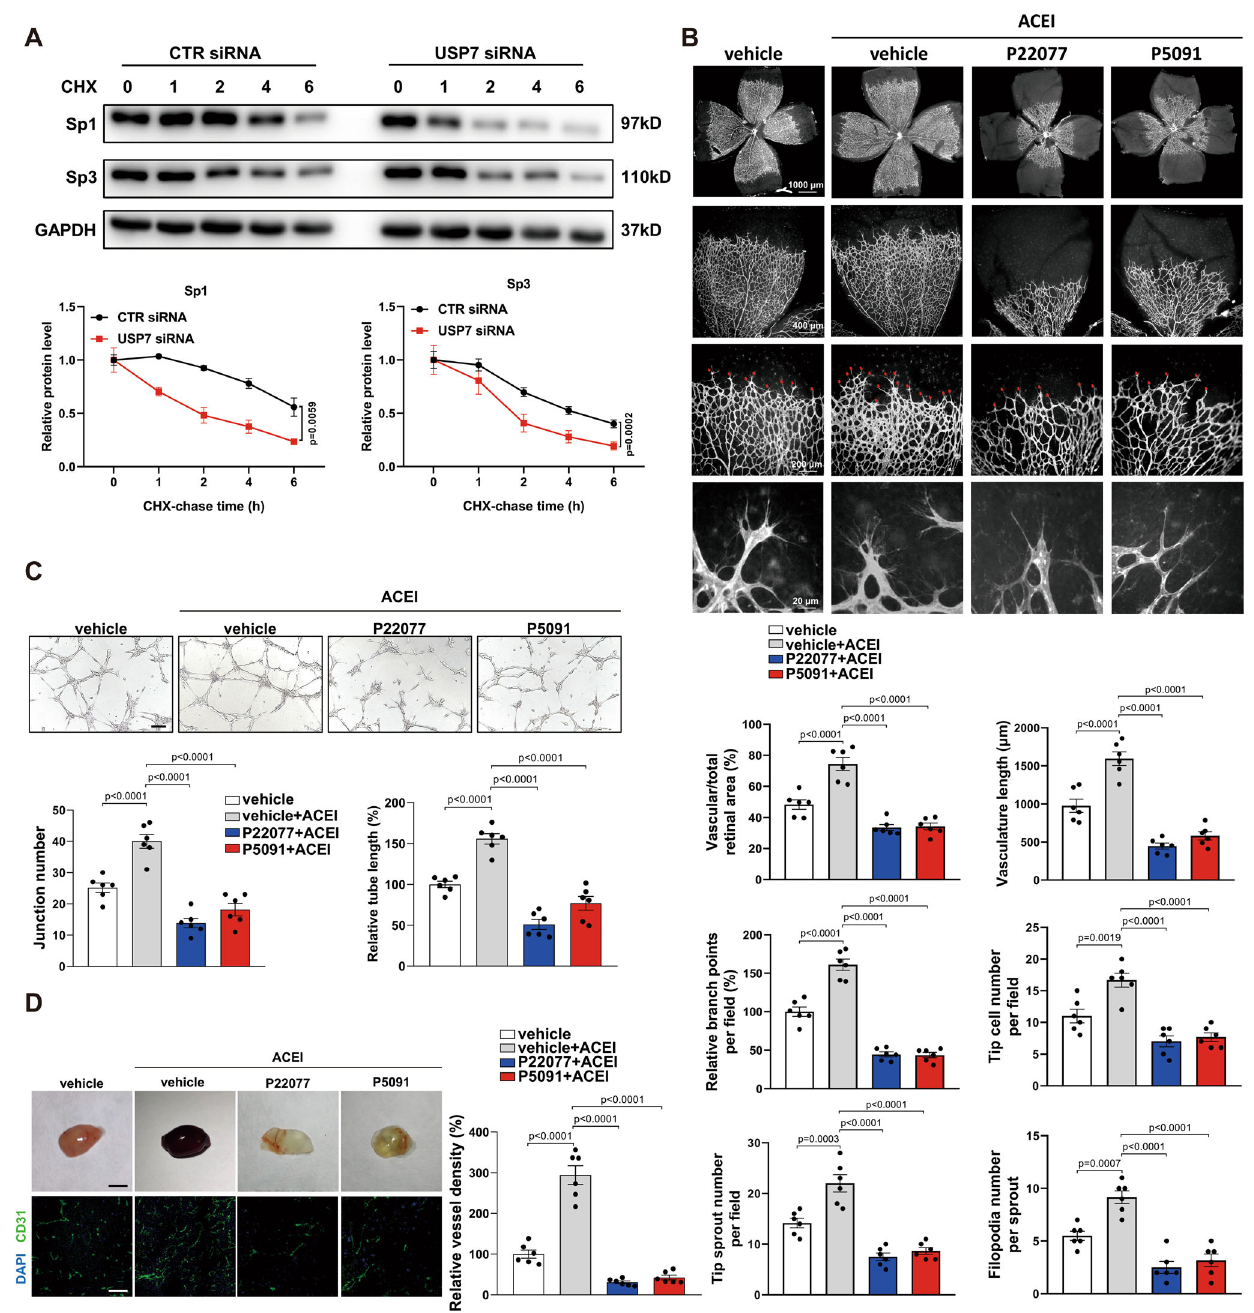
Fig. 4 | ACEIpromotesangiogenesis via USP7.A Westernblotanalysis of Sp1and Sp3 in human umbilical vascular endothelial cells (HUVECs) transfected with CTR siRNA or USP7 siRNA and treated with cycloheximide (CHX) for 0, 1, 2, 4, or 6h. Bottom, quanti fi cation of western blot. n =6. B Retinal whole-mount staining of isolectin-B4 in P5 pups treated with vehicle, vehicle + ACEI, P22077+ACEI, or P5091+ACEI. n =6. Redarrowheads showtip cellsprouting and fi lopodia.Bottom, quanti fi cation of vascular/total retinal area, vasculature length, branch points per fi eld, tip cell number per fi eld, tip sprout number per fi eld, and fi lopodia number per sprout. Scale bars: 500 (row 1), 100 (row 2), 50 (row 3), and 10 μ m (row 4). C Capillary network formation of HUVECs with different treatments on Matrigel